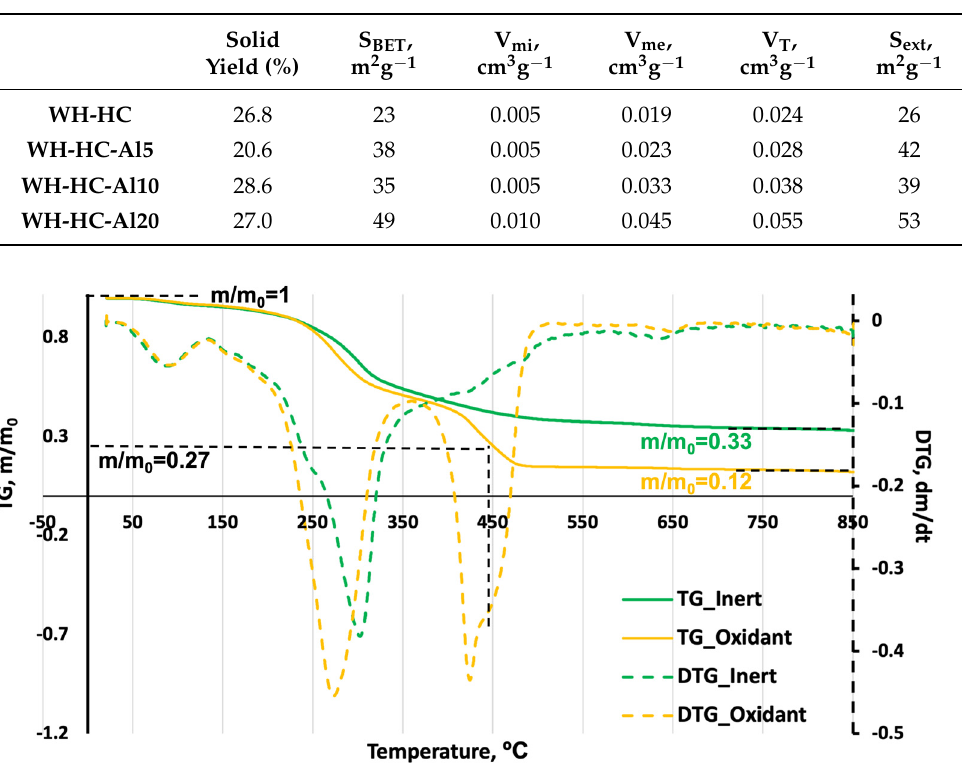
Figure 1. TGA and DTG curves of WH leaves under inert and oxidant atmosphere . Table 1. Solid yield (SY, %) and N 2 adsorption textural parameters of uncatalyzed HC and Al-cata- lyzed HCs.